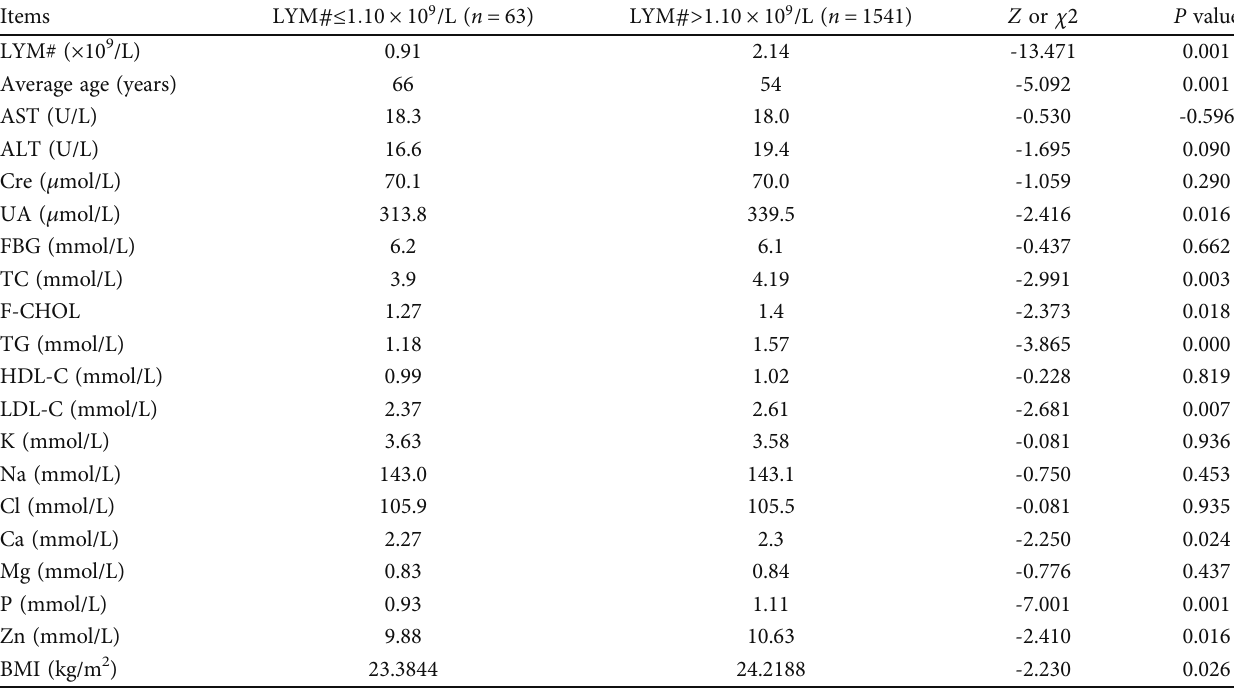
Table 2: Comparison of clinical data of patients in the LYM# ≤ 1 : 10 × 10 9 /L and LYM#>1 : 10 × 10 9 /L